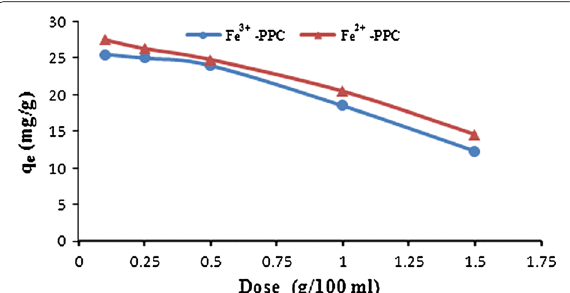
Fig. 5 The effect of composite dose on adsorption capacity. The change of adsorption capacity in removal of the Pb 2 + vs amount of adsorbents in solution for Fe 2 + -PPC is depicted in red and for Fe 3 + -PPC is depicted in